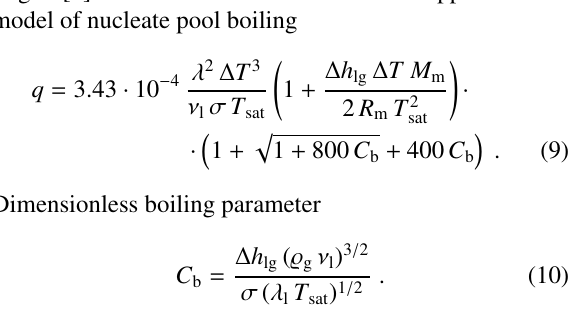
Cylinder made of borosilicate glass with internal di- ameter of 200 mm stands on stainless-steel bottom with an opening for square 48 × 48 mm stainless-steel heated block. Stainless-steel components are made of 1.4301 ac- cording to ˇCSN EN 10 0027-2. Top side of the block serves as a heating surface for liquid in the cylinder. The block stands on isolating pad made of glass and is heated by three horizontally-placed cartridge heaters with diame- ter of 10 mm, length of 60 mm and nominal power of one made of Inconol-800 with nominal power of 3 kW.